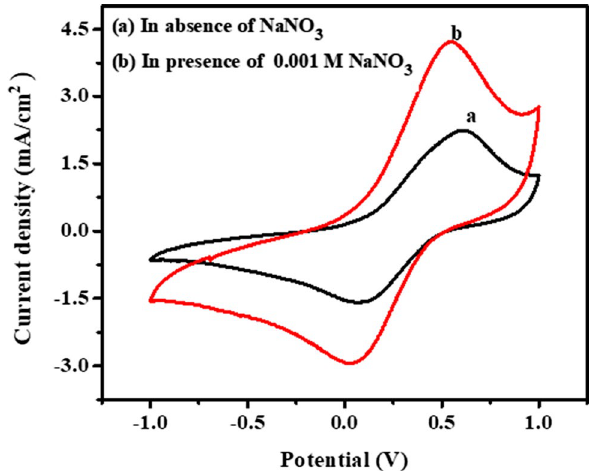
Fig. 6 CV of GCE/RGO/PPy/NR in the absence and presence of 10 mM NaNO 3 in 0.1 M KCl solution (scan rate = 100 mV s −1 )